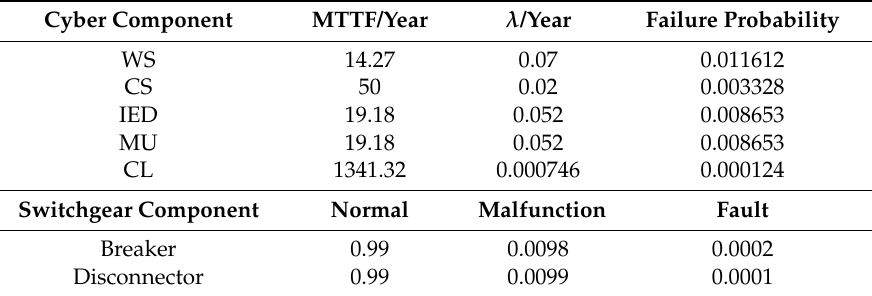
Table 2. Reliability parameter and failure probability of some CPS